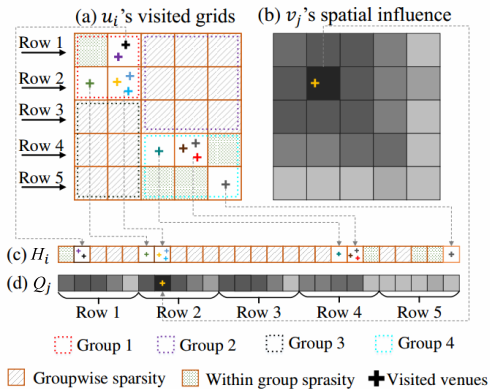
Fig. 12 Method for determining regularity term [47] .